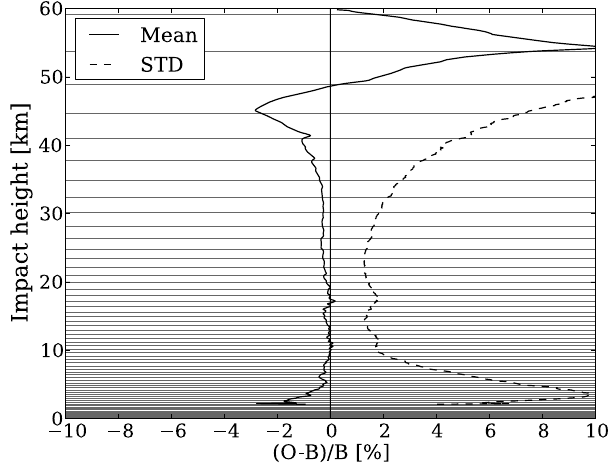
Figure 9. Bending angle innovation statistics, using hydrostatic refractivity (Eq. 10, including the moisture term) evaluated on a doubled-resolution vertical grid and using an exponential function of refractivity with height to evaluate the Abel integral between the model/pseudo-levels